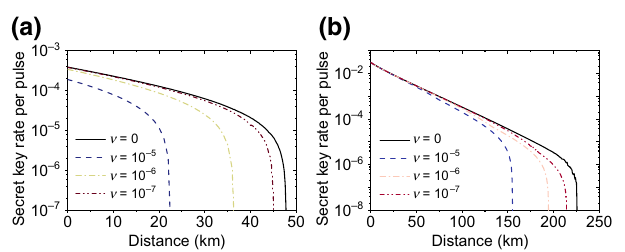
FIG. 7. Simulation of the asymptotic key rate for phase- encoding MDI QKD under two sets of parameters: (a) detector’s efficiency η det = 10%, dark count rate p dc = 10 − 5 , (b) detector’s efficiency η det = 85%, dark count rate p dc = 10 − 7 . Trojan-horse